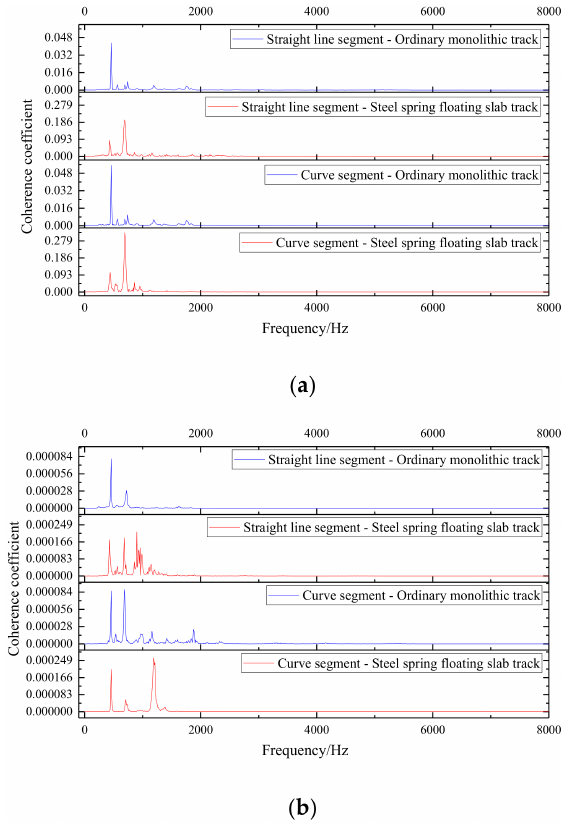
Figure 16. Comparison of acceleration cross-spectrum between various track components. ( a ) Rail– track bed; ( b ) track bed–tunnel